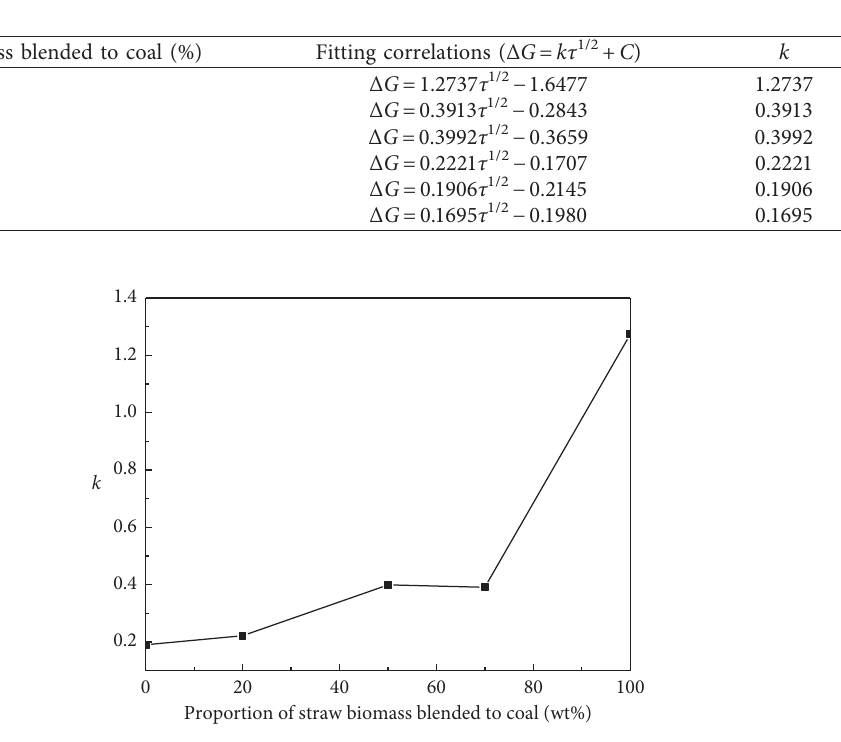
Figure 7: Curves of coefficient indicating corrosion rate versus proportion of straw biomass blended to coal. Table 6: Content of elements in different ash.